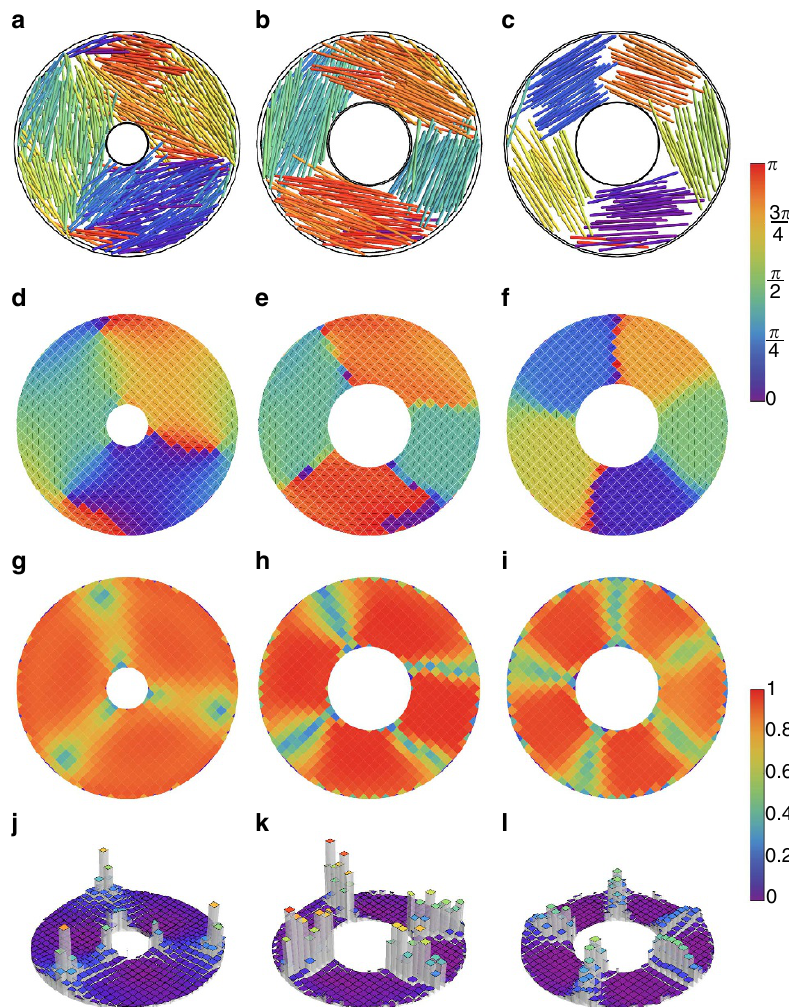
Figure 2 | Patterns of rod-like particles in annular confinement. Overview of packing structures of rod-like particles confined in annulus-shaped chambers, showing threefold (left column), fourfold (middle column) and fivefold (right column) symmetry. Top row: snapshots of simulations. Second row: particle orientations averaged over averaged over 4 10 3 configurations, labelled by colour bar on the right. Third row: scalar order parameter S A [0,1]. Fourth row: normalized angular deficit parameter. Simulation parameters for each column (from left to right): ( a , d , g , j ) H ¼ 6, L / D ¼ 15, Z ¼ 0.20 and R inner ¼ 7.5; ( b , e , h , k ) H ¼ 6, L / D ¼ 25, Z ¼ 0.20 and R inner ¼ 15; ( c , f , i , l ) H ¼ 3, L / D ¼ 25, Z ¼ 0.20 and R inner ¼ 15. For error calculations see Supplementary Note 8 and Supplementary Fig.